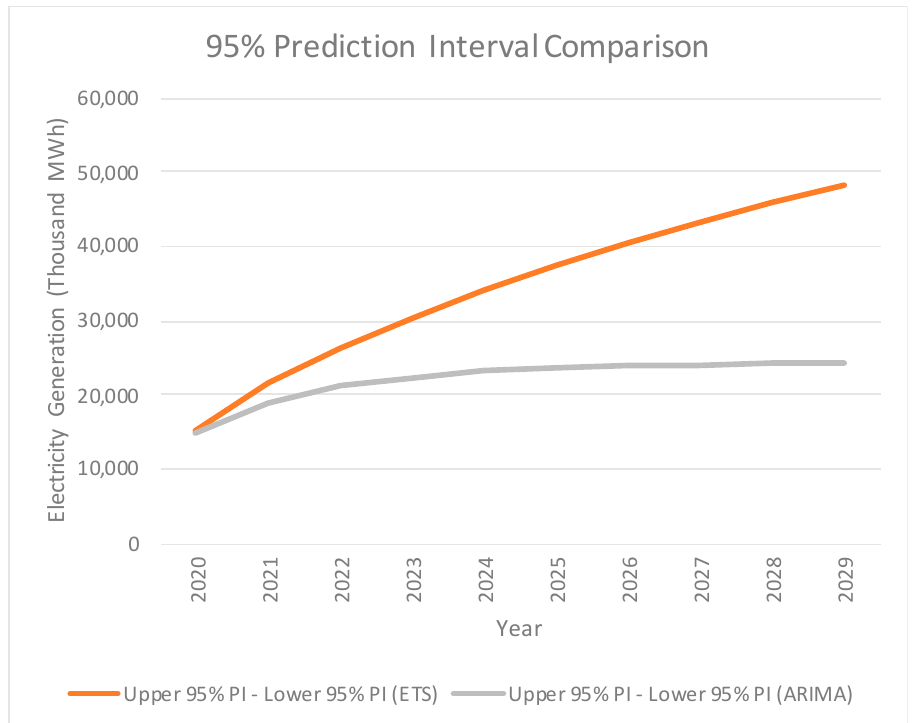
Figure 6. 95% Prediction Interval Width Comparison.